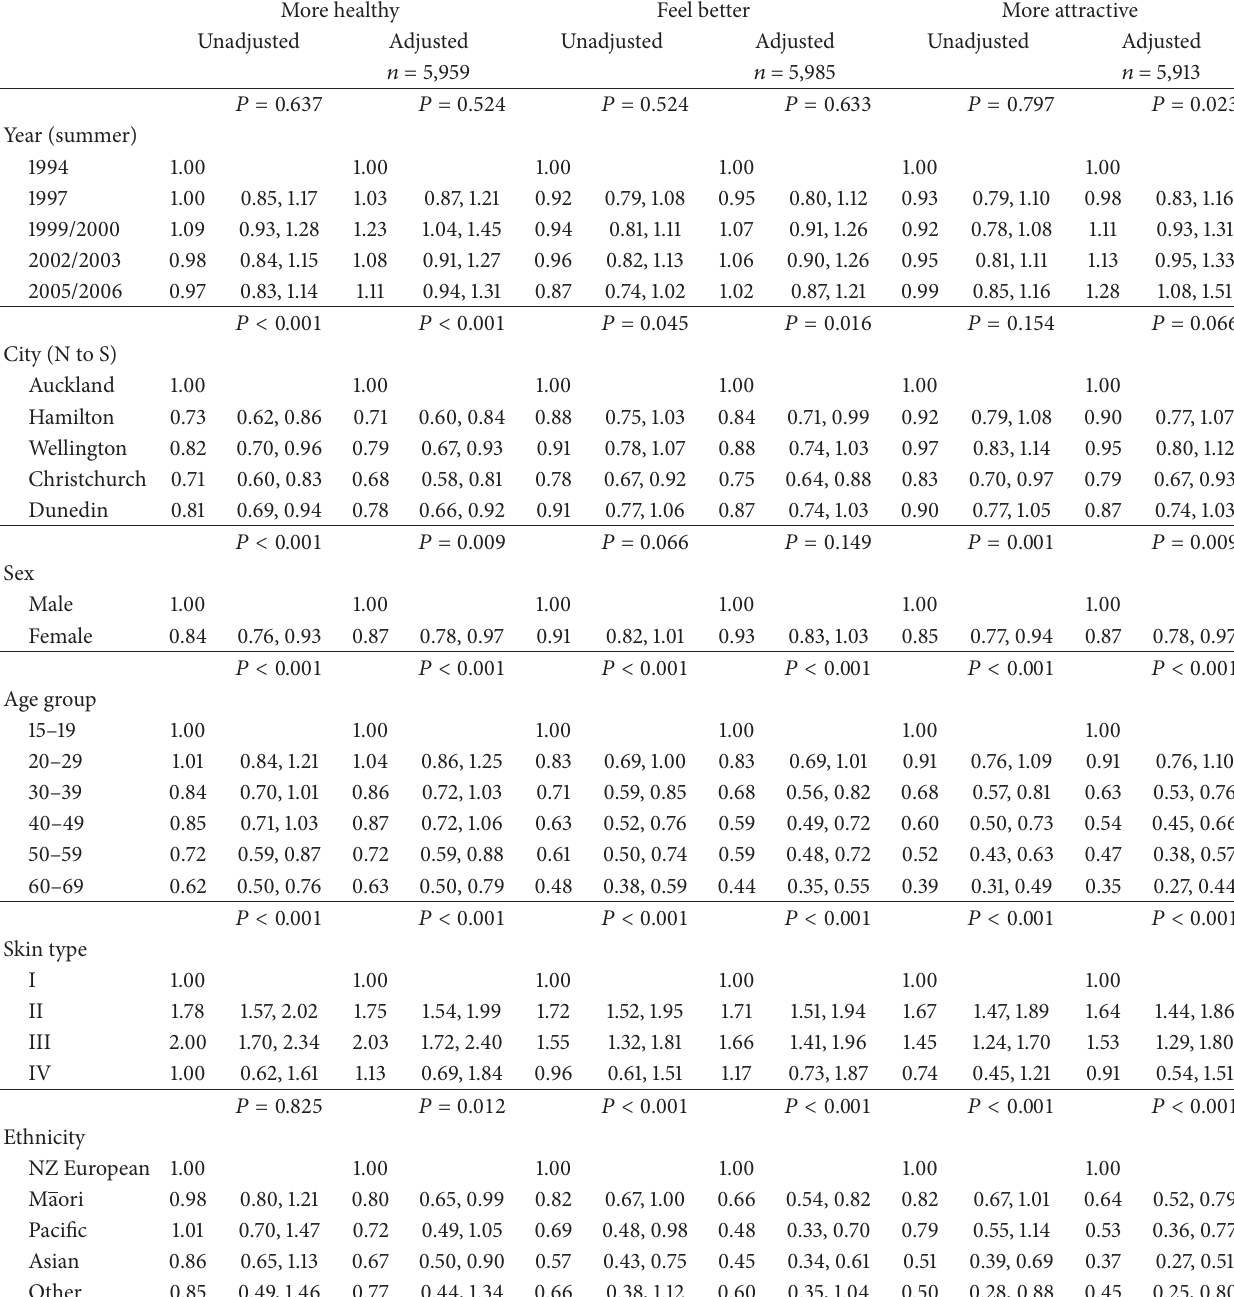
Table 2: Unadjusted and adjusted ∗ odds ratios and 95% confidence intervals for personal perceptions by sample